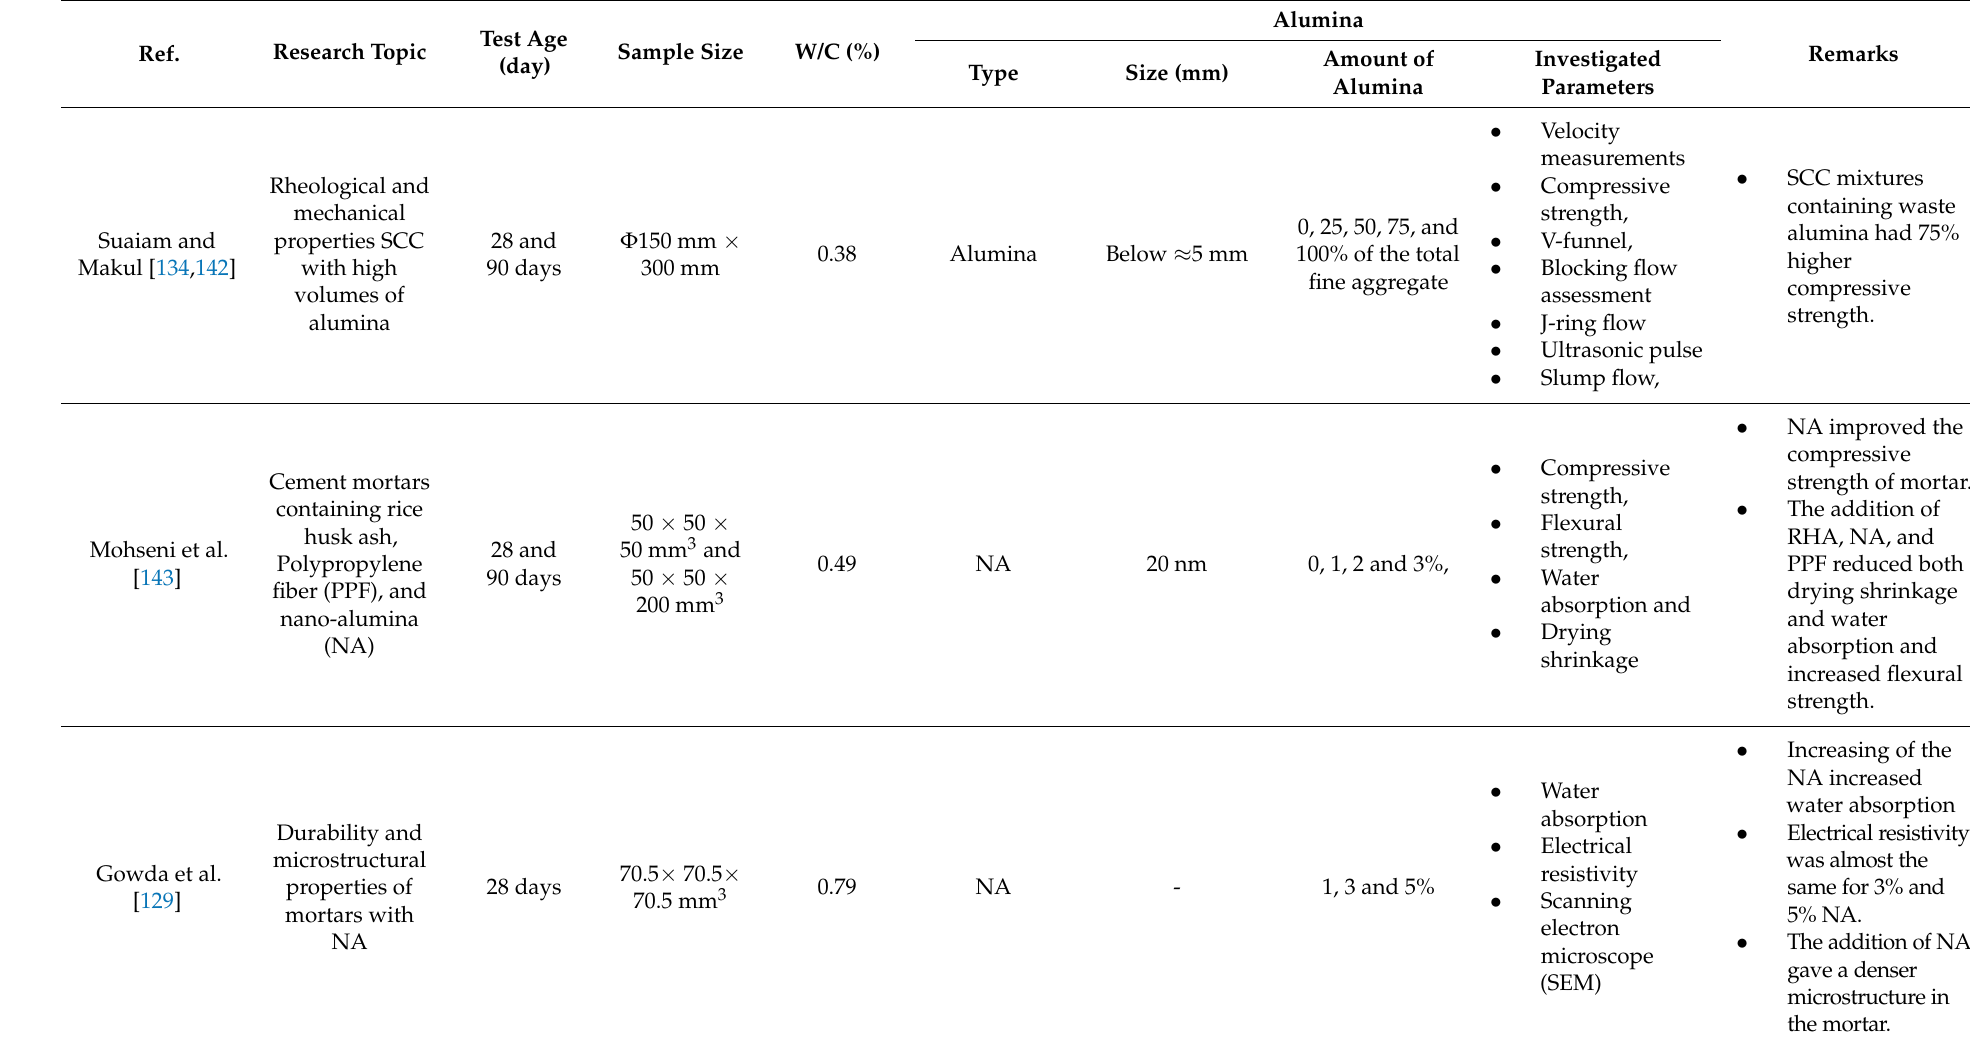
Table 4. Summary of the literature on the application of nano-alumina (NA) in SCC.